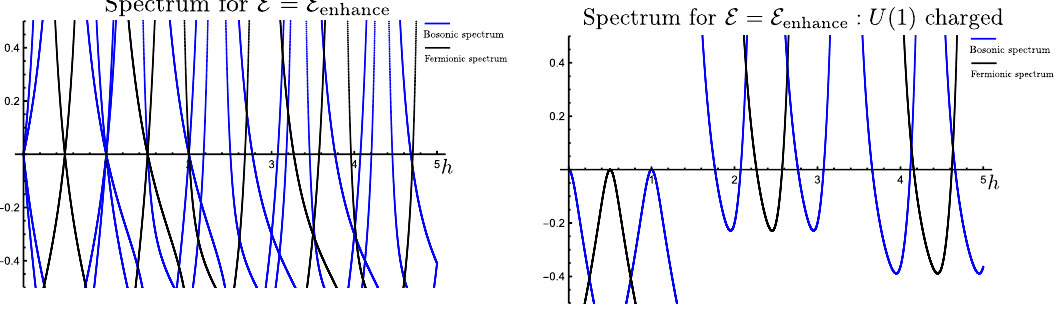
Figure 16 . Top: the bilinear spectrum for U (1) neutral sectors at the enhancement point, cosh − 1 3 E enhance = 1 . Bottom: the bilinear spectrum for U (1) 2 π 2